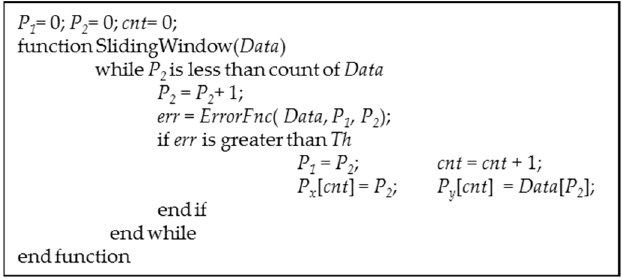
Figure 4. Pseudo codes of standard sliding window method.